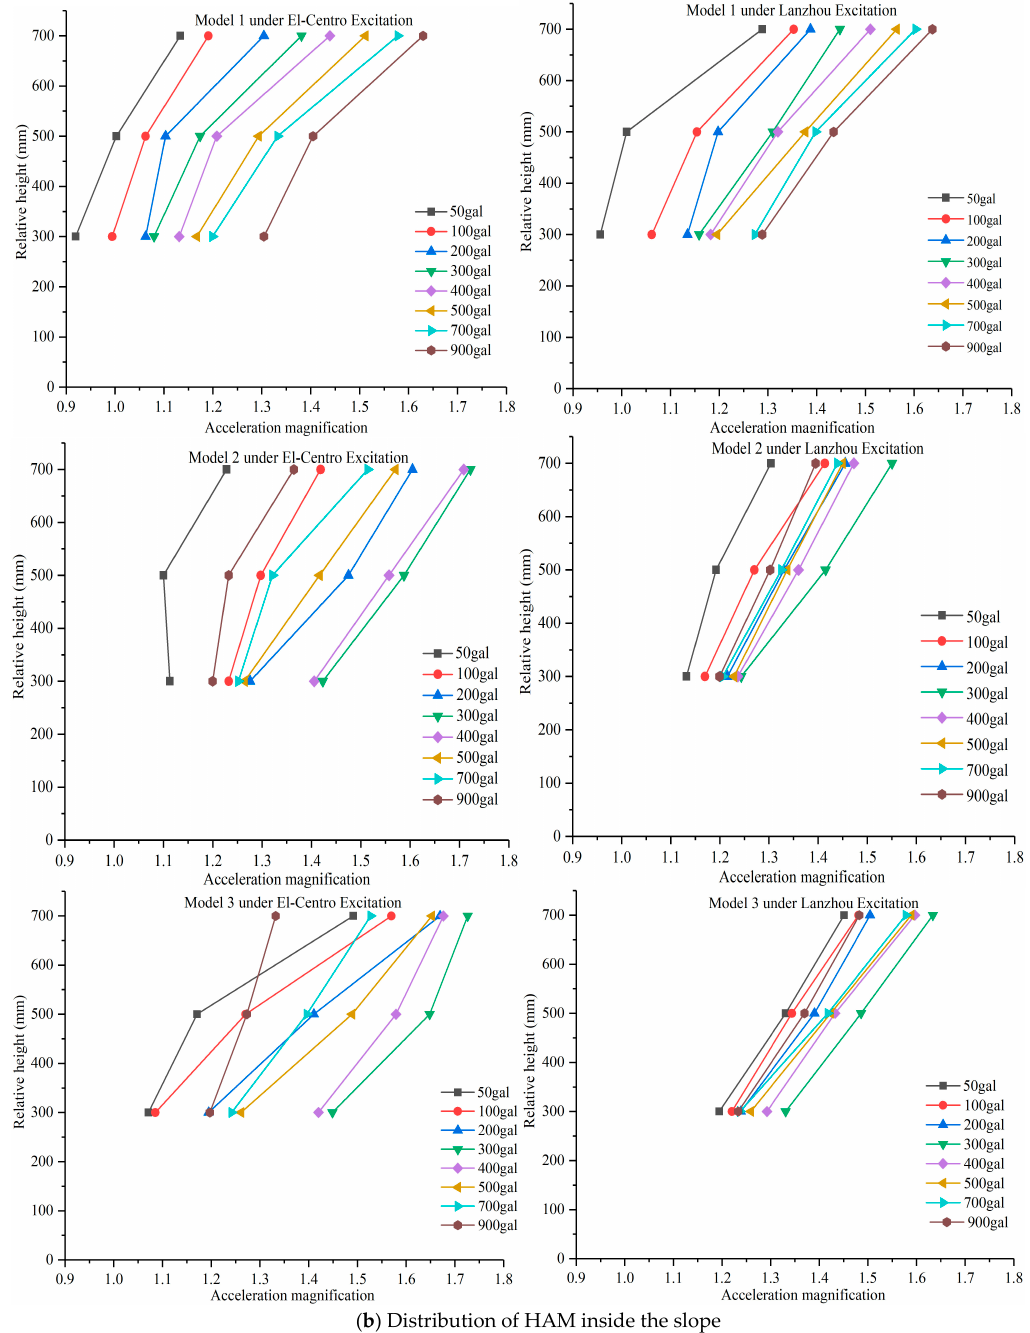
Figure 10. Distribution of HAM (1 gal = 1 cm/s 2 ): ( a ) slope surface ( b ) inside the slope.